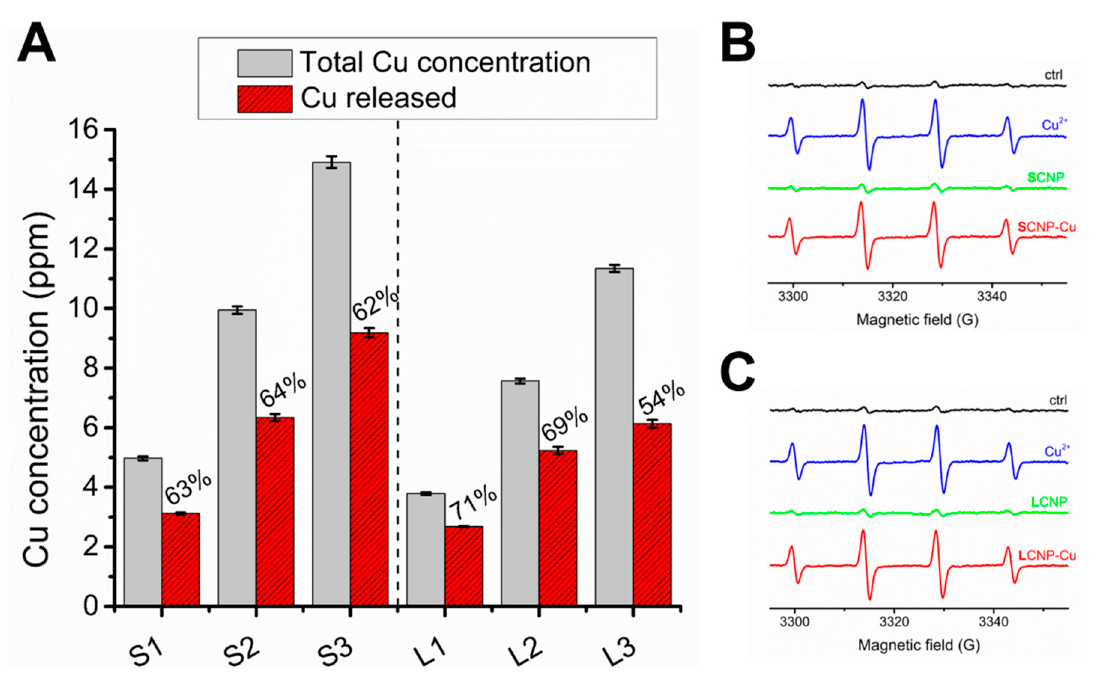
Figure 3. Release of copper in the BHI broth and ROS generation by CNPs. ( A ) Concentration of copper in BHI broth following incubation with three different concentrations of SCNP-Cu (S1-S3) or LCNP-Cu (L1-L3) for 24 h (red columns) detected by ICP-OES in comparison with the theoretical concentration of copper relative to total release (black columns). ( B , C ) EPR spectra generated by ( B ) SCNP and SCNP-Cu and ( C ) LCNP and LCNP-Cu after 60 min of incubation in the presence of 88 mM DMPO and 40 mM H 2 O 2 in 4 mM PBS at pH 7.4.